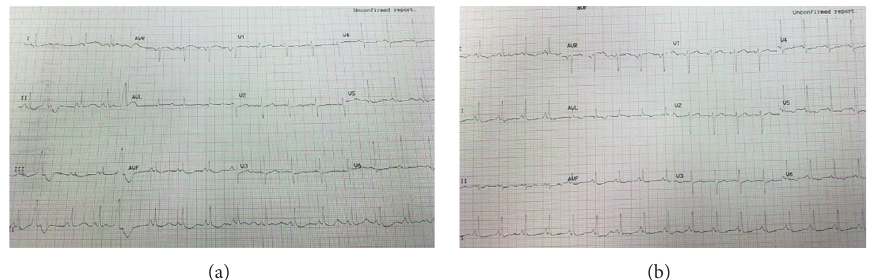
Figure 1: (a) ECG showing VPCs. (b) ECG eight hours later with T-wave inversion and ST depression in leads I, aVL, V 5 , and V 6 .